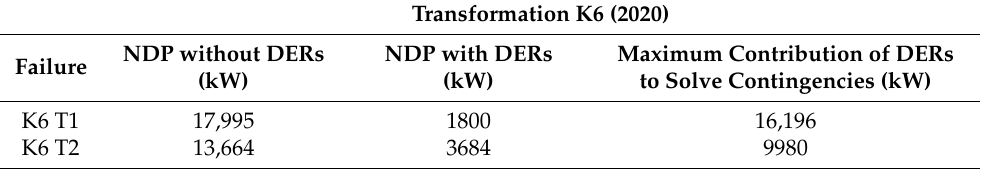
Table 4. Transformation K6 under contingency: distributed energy resources (DER) ancillary services